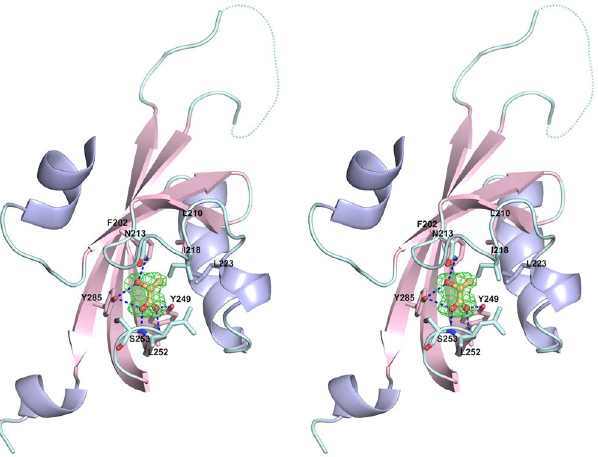
Figure 4. Architecture of ligand-binding site in membrane-proximal module of TlpC dCACHE domain. The (mFo - DFc) σ A -weighted electron density for lactate is shown in green. The map was calculated at 2.2 Å resolution and contoured at the 3.0 σ level. The lactate molecule is shown in all-atom ball-and-stick representation with C atoms coloured orange. The protein side chains that form direct contacts with lactate are shown in stick